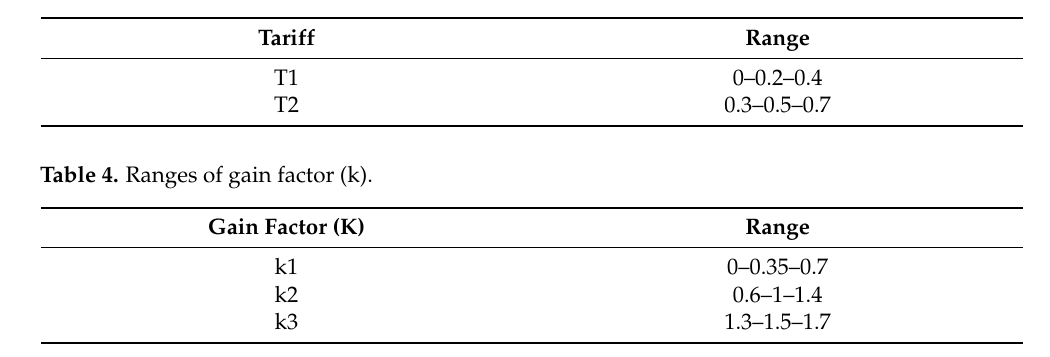
Table 3. Range of tariff.